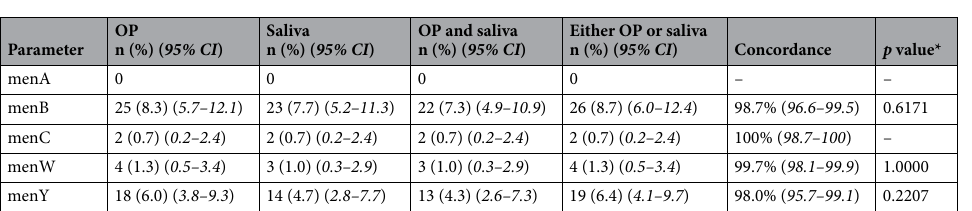
Figure 4. A scatter plot of the ctrA and genogroup-specific qPCR cycle threshold (C T ) values. Results are displayed for oropharyngeal ( A – E ) and saliva ( F – J ) samples. Each dot represent an individual sample. Samples with a C T for both ctrA and a particular genogroup below 25 C T are considered as positive for that particular genogroup. Yellow dots represent samples classified as positive for a genogroup by qPCR and grey dots as negative for the depicted genogroup. Dashed lines depict the C T criterium for meningococcal carriage.